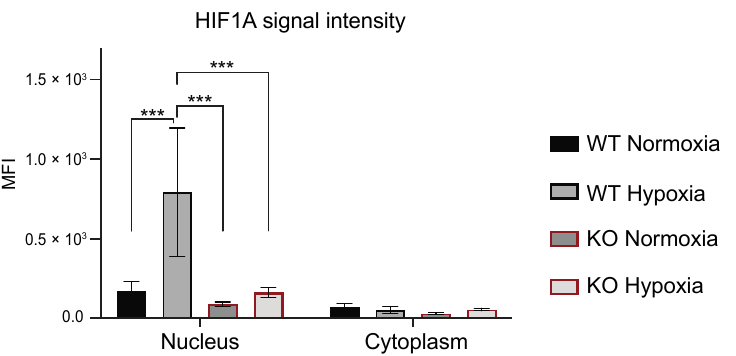
Figure 3. Staining of HIF1A in HIF1A KO and WT HUVECs. ( a – d ): One representative image of the stained HIF1A KO and WT HUVECs, which were stained with Hoechst (blue), anti ‐ actin (green), and anti ‐ HIF1A (red). ( a ): WT HUVECs cultured in normoxic conditions. ( b ): WT HUVECs cultured in hypoxic conditions. ( c ): HIF1A KO HUVECs cultured in normoxic conditions. ( d ): HIF1A KO HUVECs cultured in hypoxic conditions. ( e ): Quantification of the HIF1A signal intensity (MFI) in the nucleus and the cytoplasm in WT and KO HUVECs in normoxic and hypoxic conditions, which is compared by two ‐ way ANOVA multiple comparisons test, *** p ≤ 0.001. The experiment was per ‐ formed with one biological replicate at p. 3 ( n = 3) and five images were taken per well. Scale bar 10 μ m.